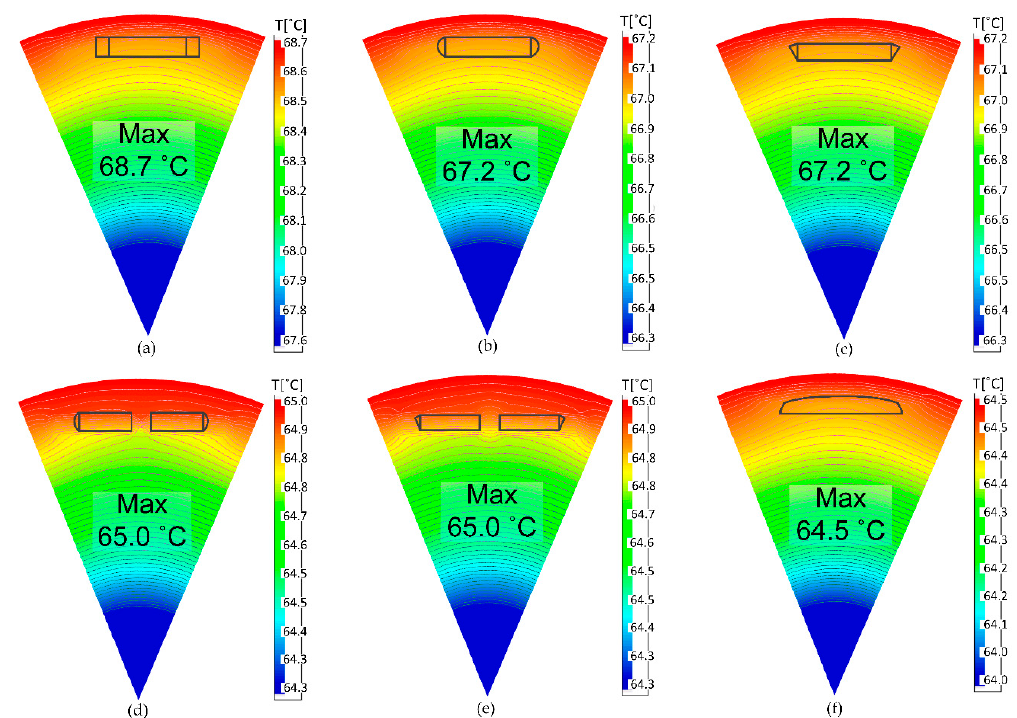
Figure 8. Temperature distribution in the considered IPMSM rotors with ( a ) R-ROW, ( b ) R-SOW, ( c ) R-IOW, ( d ) RCL-SOW, ( e ) RCL-IOW, and ( f ) H-NOW arrangements.